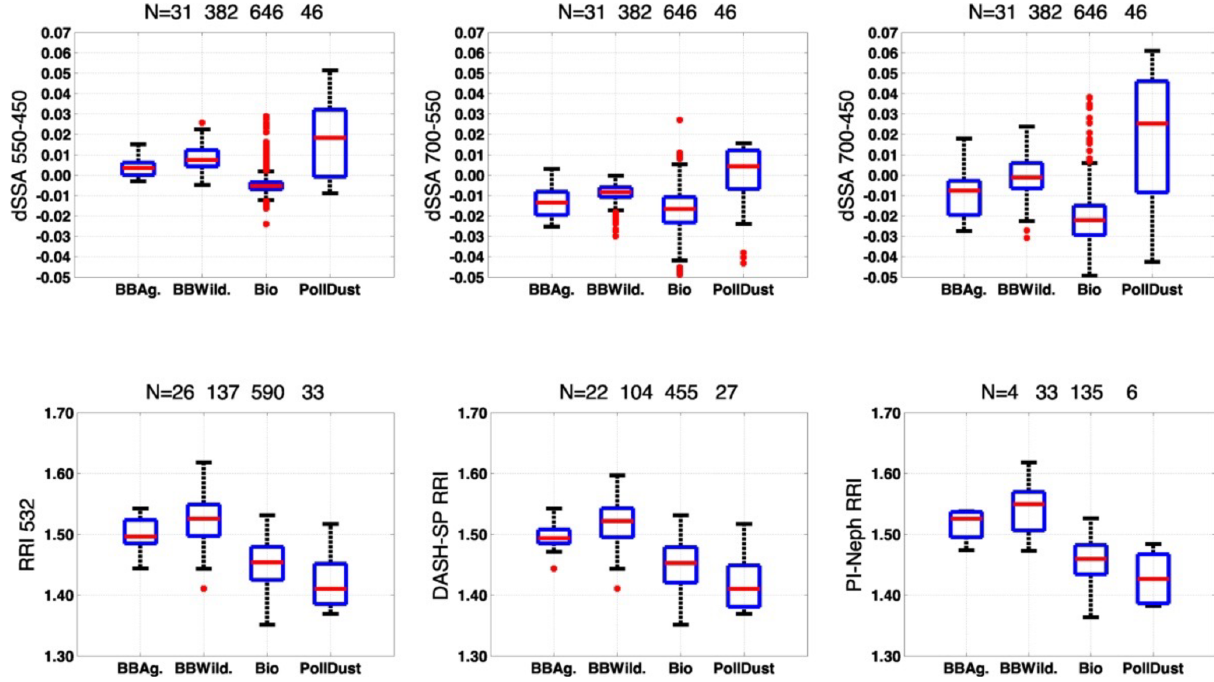
Figure A4. The dSSA (700–450nm, 550–450nm, 700–550nm), RRI (from DASH-SP and PI-Neph), RRI from DASH-SP and RRI from PI-Neph at 532nm per PS-AMT. In each blue box, the red horizontal line indicates the median, and the bottom and top edges of the box indicate the 25th and 75th percentiles, respectively. The black whiskers extend to the most extreme data points not considered outliers, and the outliers are plotted individually using red points. RRI: real refractive index; dSSA: difference in single scattering albedo. Numbers in the title correspond to the number of points behind each box–whisker plot for the respective BBAg., BBWild., Bio. and PollDust